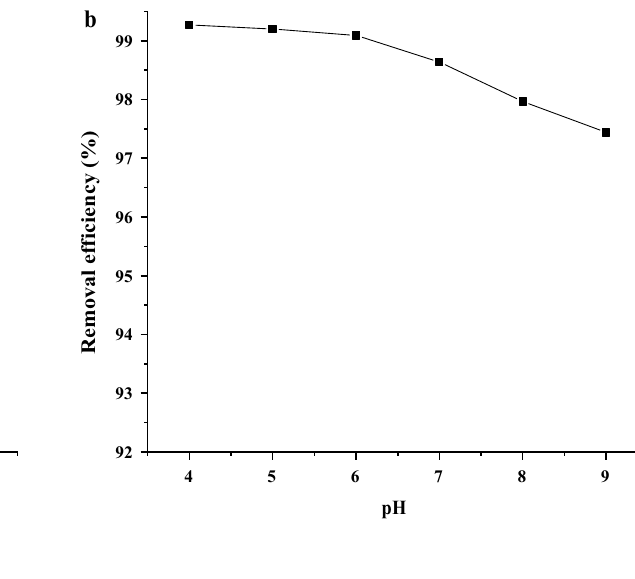
Fig. 5 Variation of U removal with solution pH in a FA and b TW